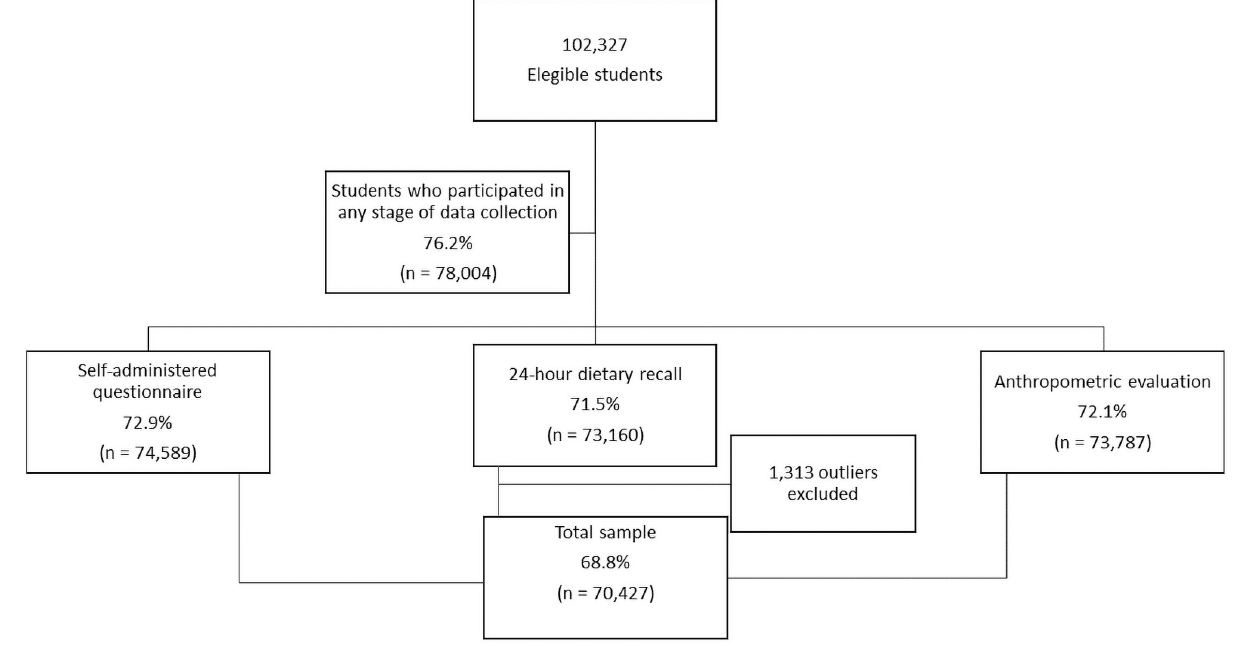
Fig 1. Flowchart of eligible adolescents and the total study